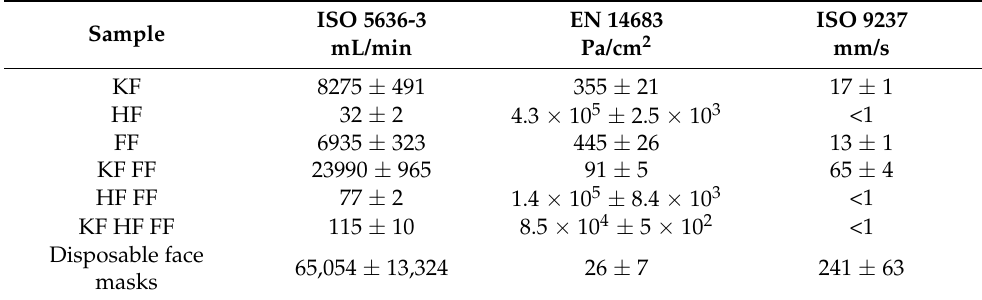
Table 2. Air permeability of composite materials and disposable face masks ( ± standard deviation). KF—-kraft fibers, HF—-hemp fibers, and FF—-fungus